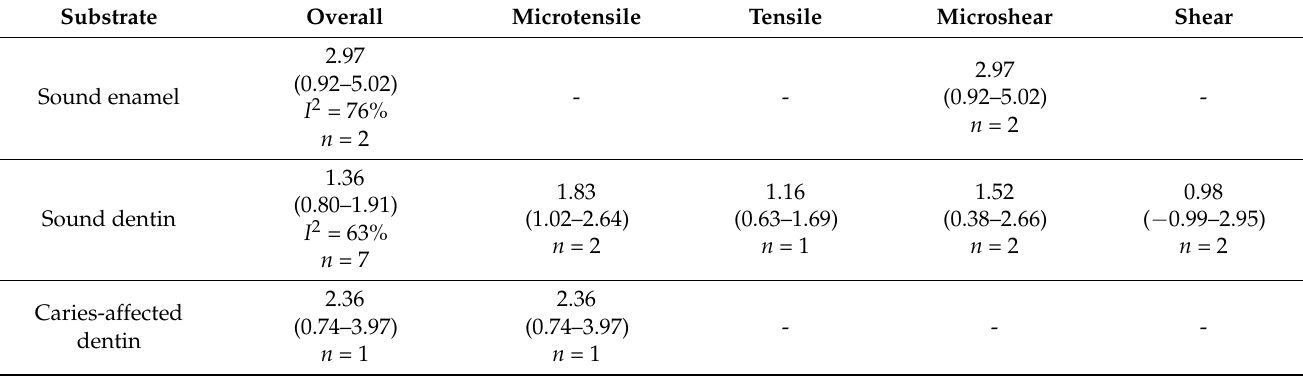
Table 3. Pooling of immediate bond strength data (MPa) considering the bond strength test in various substrates in primary teeth.